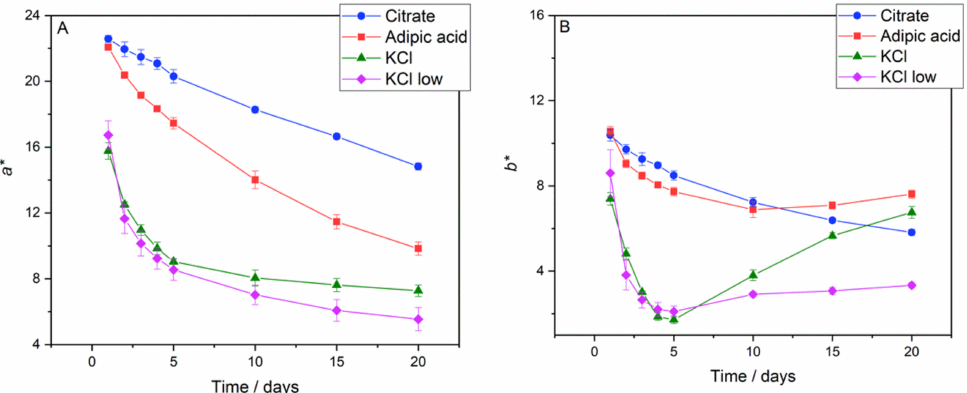
Figure 3. The CIE L*a*b* colour parameters a* (Panel ( A )) and b* (Panel ( B )) for W 1 /O/W 2 emulsions. The 0.1 M citrate buffer system is represented by circles, 0.1167 M adipic acid by squares, 0.35 M KCl by triangles, and 0.0075 M KCl by